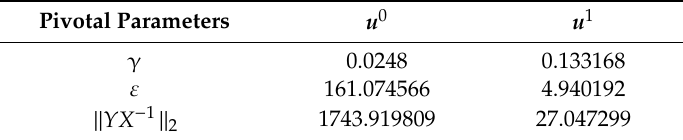
Table 2. Comparison of solutions for proposed controllers.